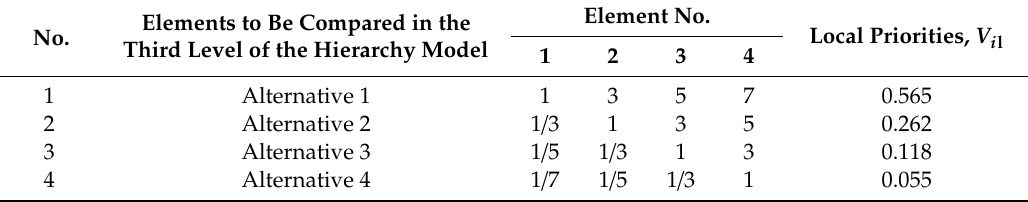
Table 7. Matrix of pairwise comparisons for the elements of the third level by the criteria “net profit”. Elements to Be Compared in the Third No. Level of the Hierarchy Model Alternative 1